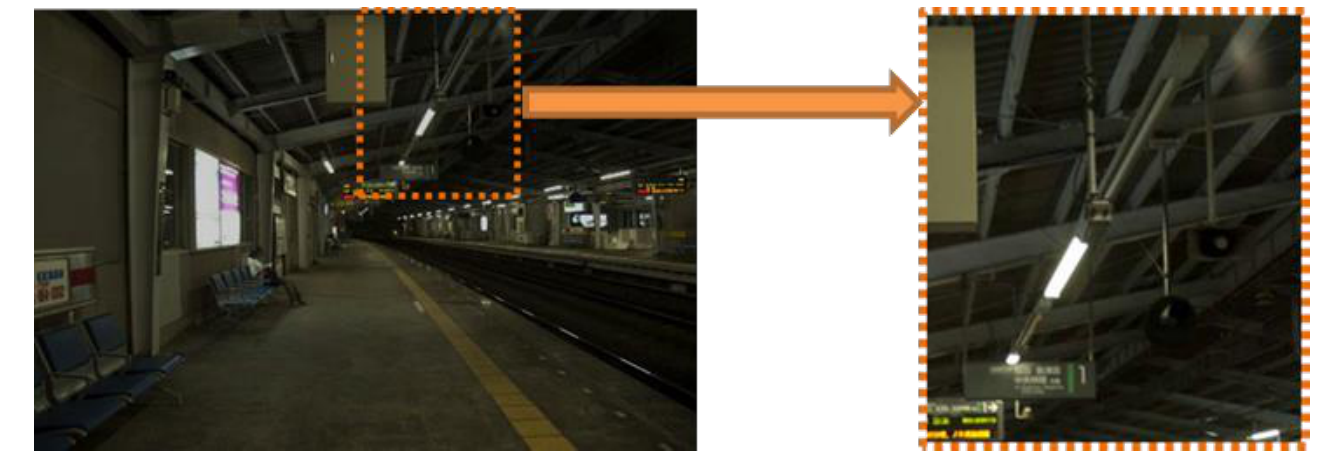
Figure 4. Lighting operation status of platform No. 14.